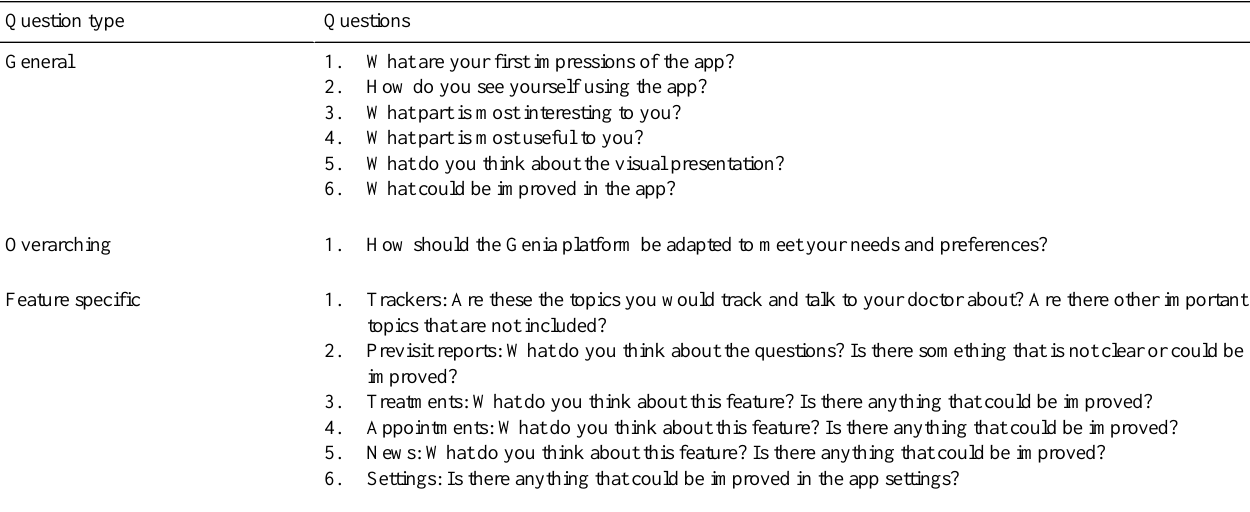
Table 1. Semistructured guide for focus group